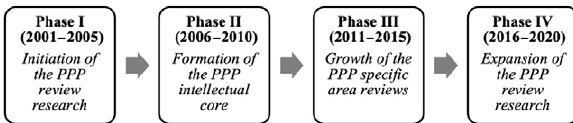
Figure 3. Evolution of the PPP review